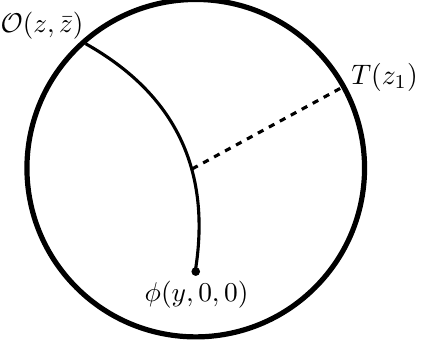
Figure 2 . Dashed (solid) lines are graviton (scalar)